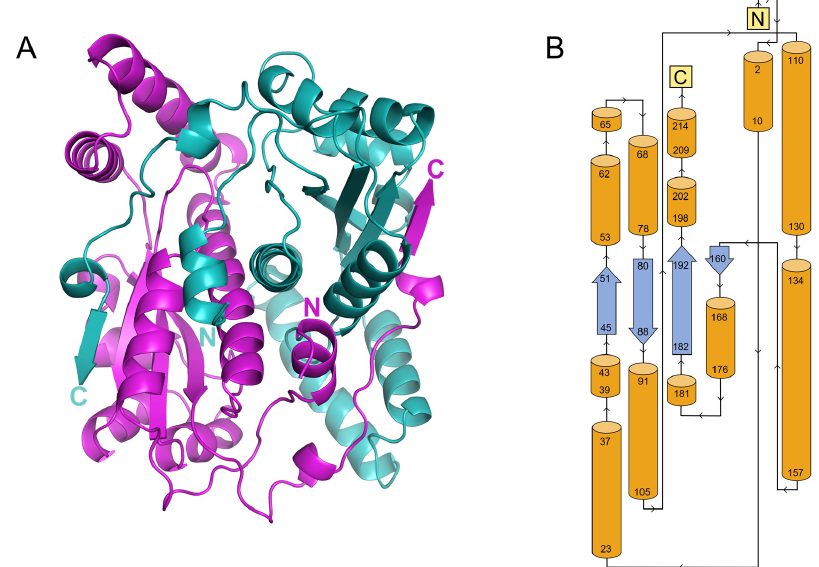
Figure 2. Cartoon structural representation of NTR 2.0. ( A ) Side view of NTR 2.0 homodimer where individual monomers are coloured cyan or magenta and N and C termini are labelled. ( B ) Topology structure diagram of NTR 2.0 monomer. Numbers represent residue positions. Orange cylinders represent α -helices and blue arrows represent β -strands.